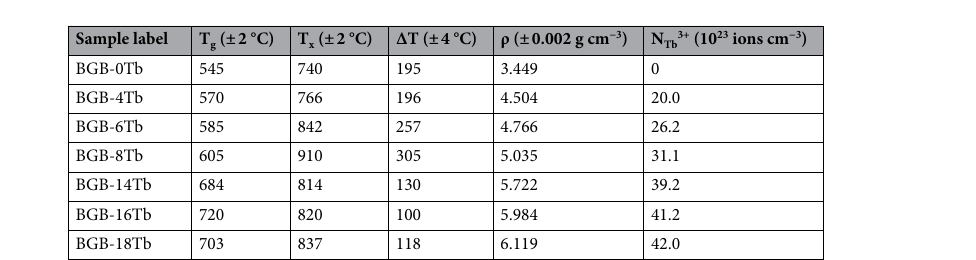
Figure 2. ( a ) DSC curves, ( b ) T g and ΔT, and ( c ) optical basicity, as a function of Tb 4 O 7 concentration. The lines in ( b ) and ( c ) are just guides for the eyes.